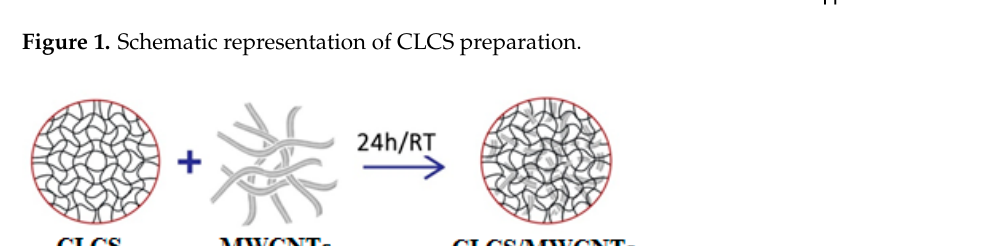
Figure 1. Schematic representation of CLCS preparation.